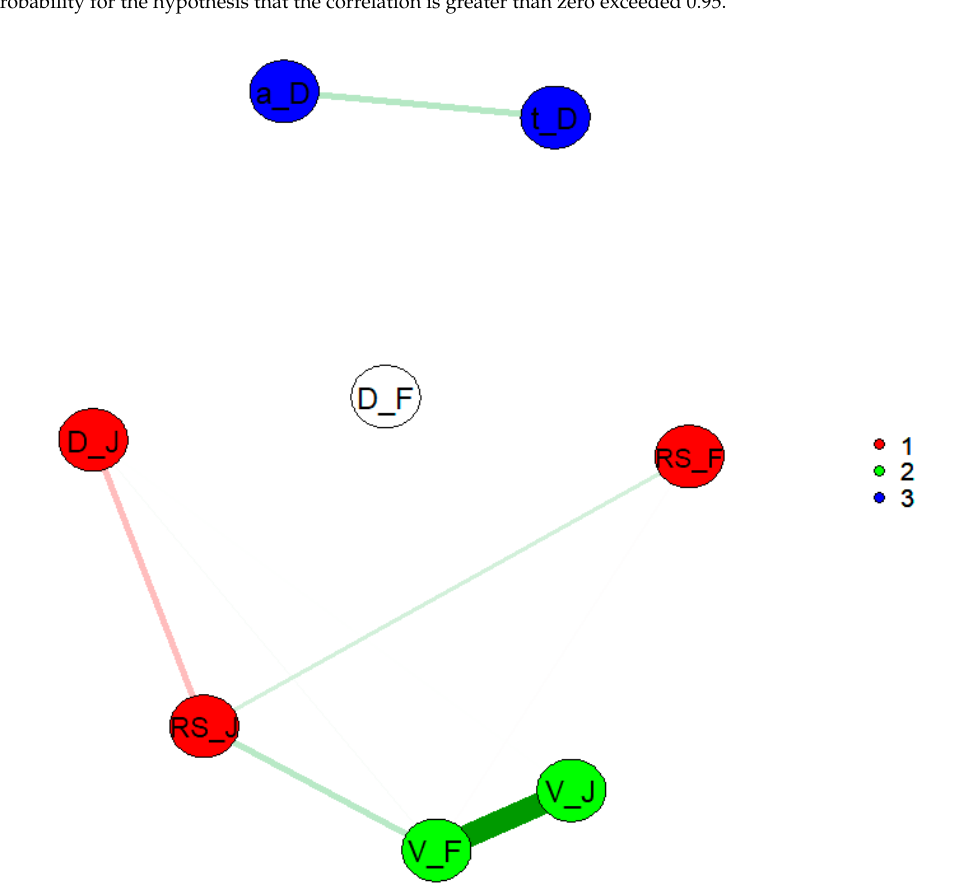
Figure 1. Exploratory graph analysis of the openness and idea density indicators for the creativity dataset. V_J = variety based on journals; D_J = disparity based on journals; RS_J = Rao-Stirling based on journals; V_F = variety based on first authors; D_F = disparity based on first authors; RS_F = Rao- Stirling based on first authors; a_D = idea density based on abstracts; t_D = idea density based on titles.